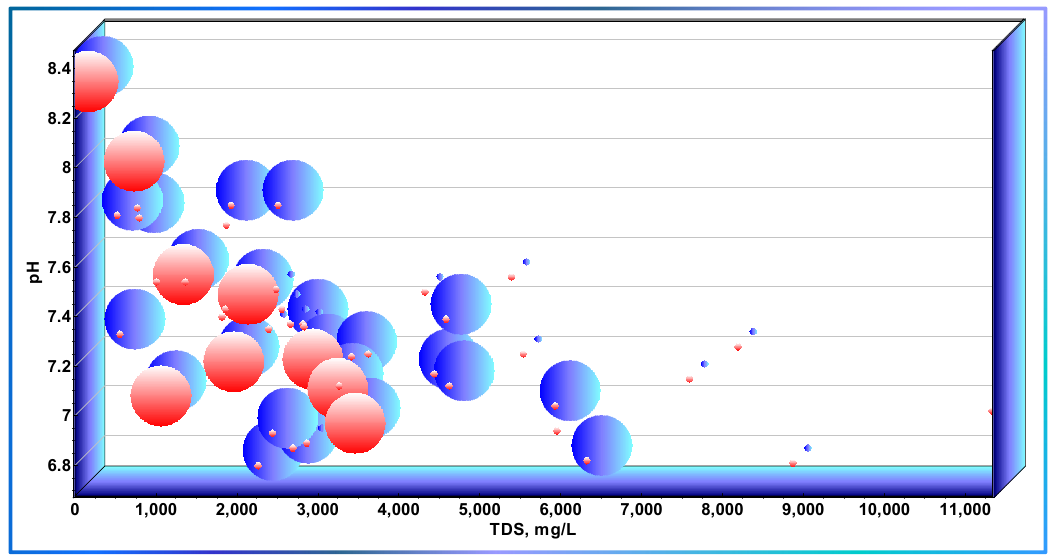
Figure 6. Bubble plot of the TDS and pH combined interaction on TC ( blue ) and E. coli ( red ).